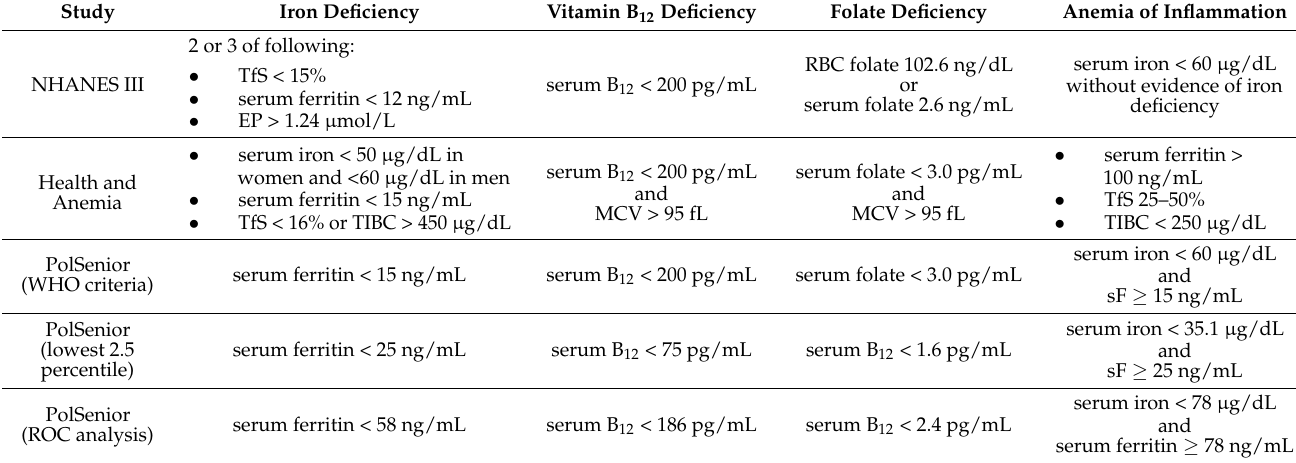
criteria, we determined the percentage of each type of anemia (Table 2). Table 6. Criteria of nutritional deficiency and anemia of inflammation in NHANES III study, “Health and Anemia” study, and PolSenior study (in the latter criteria established according to three different